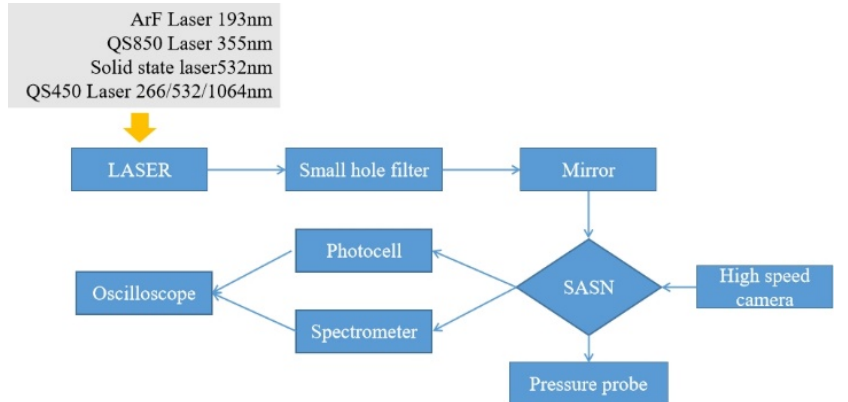
Figure 2. Schematic diagram of platform system composition.